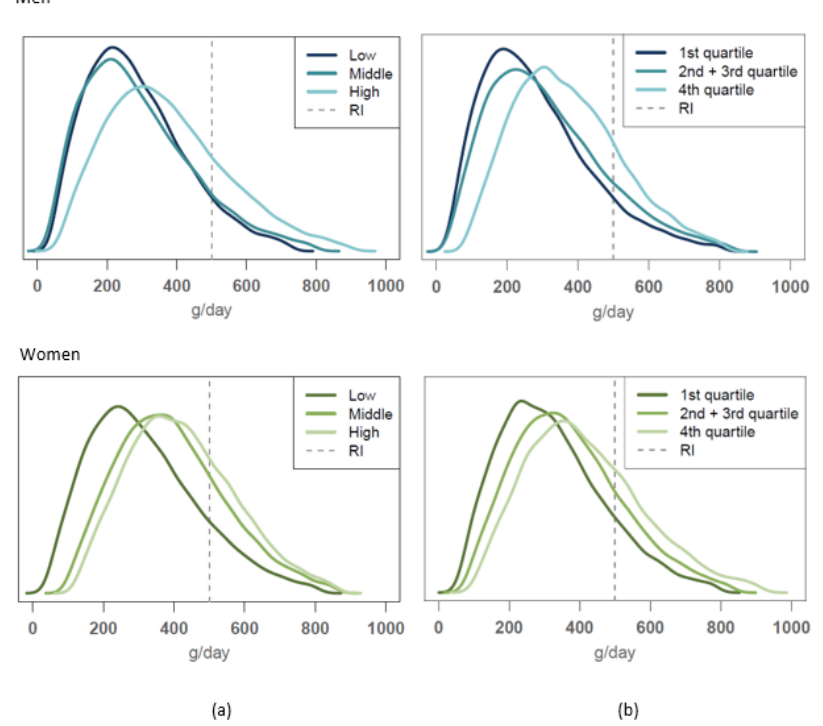
Figure 1. Usual intake distribution of vegetables and fruit consumption compared to the dietary guideline (recommended daily intake (RI); marked as dashed line) of minimally 500 g/day among men (upper figures) and women (lower figures) according to ( a ) educational group, ( b ) income level.